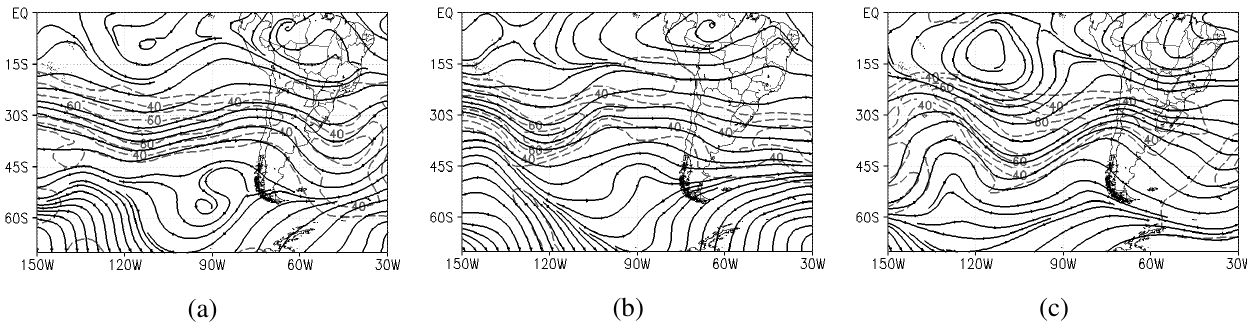
Fig. 12 – 200-hPa flow field for (a) 31 Aug, (b) 03, (c) 07 Sep 1999 at 00 UTC. Darker lines are streamlines and lighter lines are Fig. 12. 200-hPa flow field for (a) 31 August, (b) 3, (c) 7 September 1999 at 00:00 UTC. Darker lines are streamlines and lighter lines are isotachs, drawn at intervals of 20 m s -1 starting from 30 m s -1 . isotachs, drawn at intervals of 20ms − 1 starting from 30ms − 1